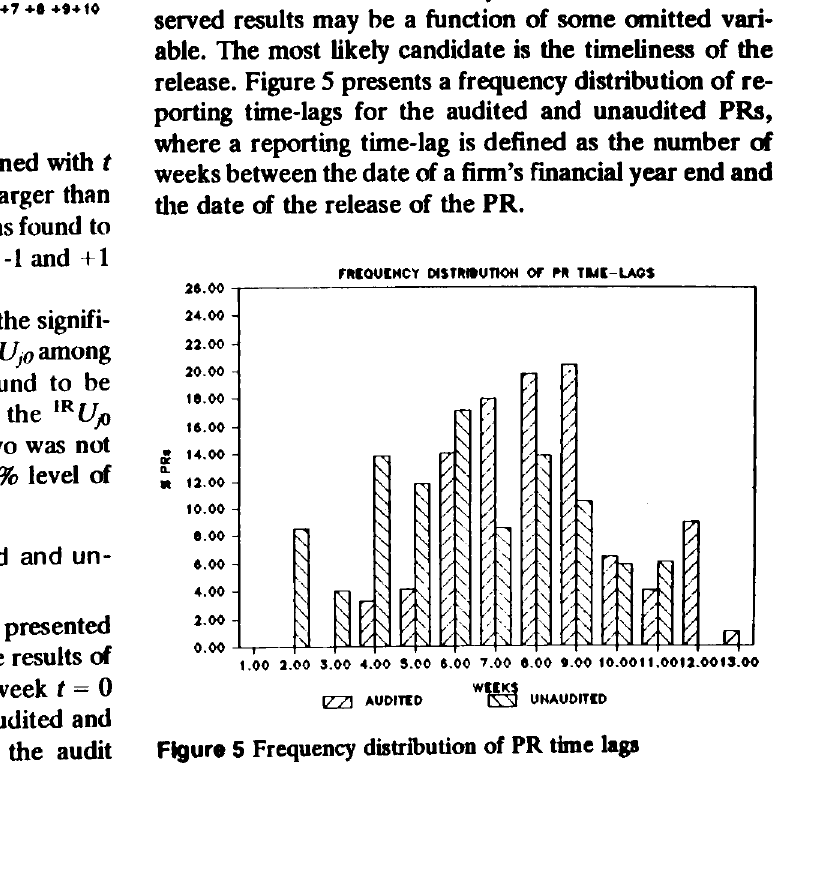
Figure 5 Frequency distribution of PR time